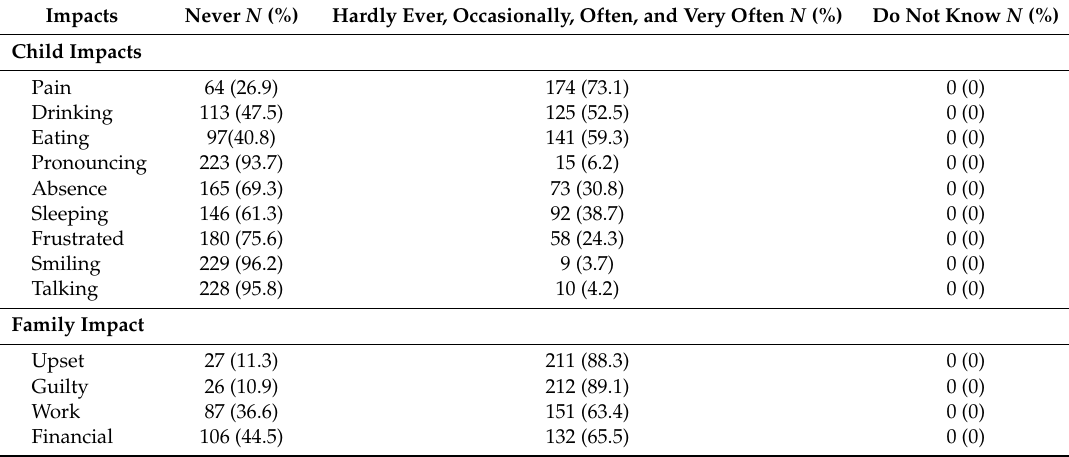
Table 2. Distribution of ECOHIS responses for the whole sample ( N =